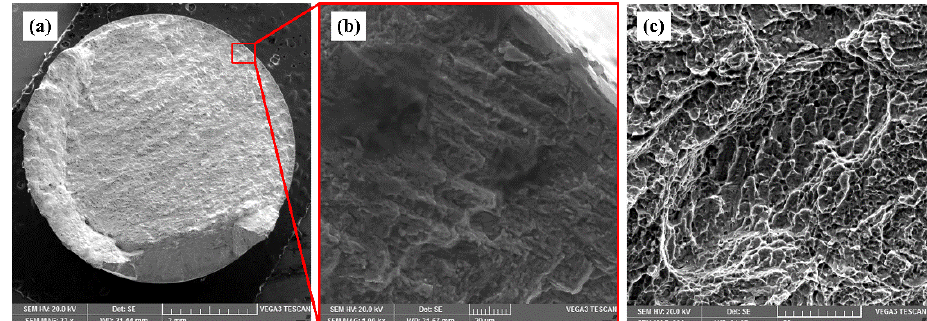
Figure 14. Scanning electron microscopy (SEM) micrographs of low cycle fatigue (LCF) fracture surface for as-built selective laser melting (SLM) Ti – 6Al – 4V tested at strain amplitude of 1.2%: ( a ) macro – fractograph, ( b ) crack initiation and propagation from the surface, and ( c ) final rupture region.